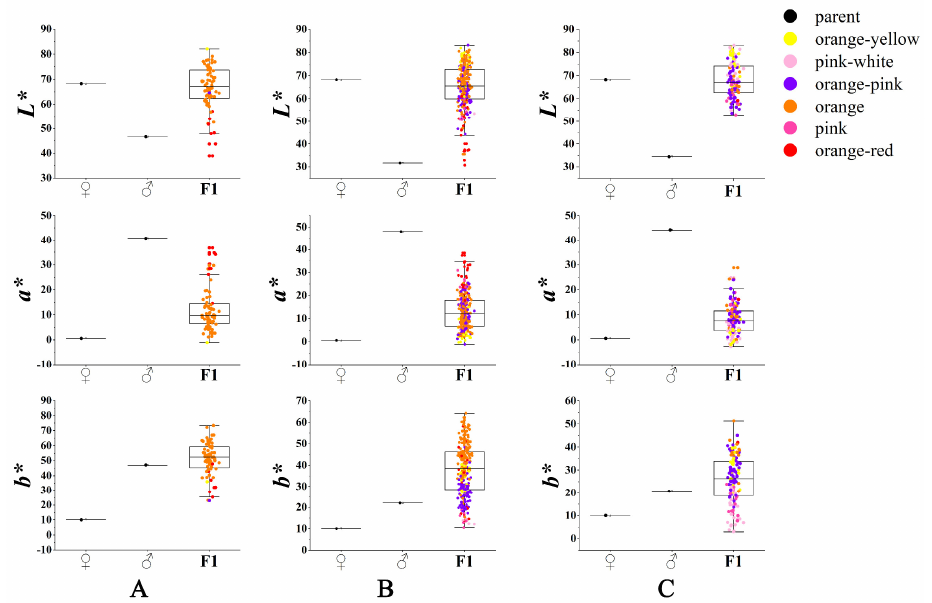
Figure 6. Box plots showing the variation and distribution of flower color data ( L*, a*, and b* value) of parents and hybrids in three combinations. ( A – C ): L* , a* , and b* value distribution in combinations of EW01, EW02, and EW03; X -coordinate: parents ( , maternal parent; , paternal parent) and F1 ♀ ♂ plants; Y -coordinate: L* , a* , and b* value,